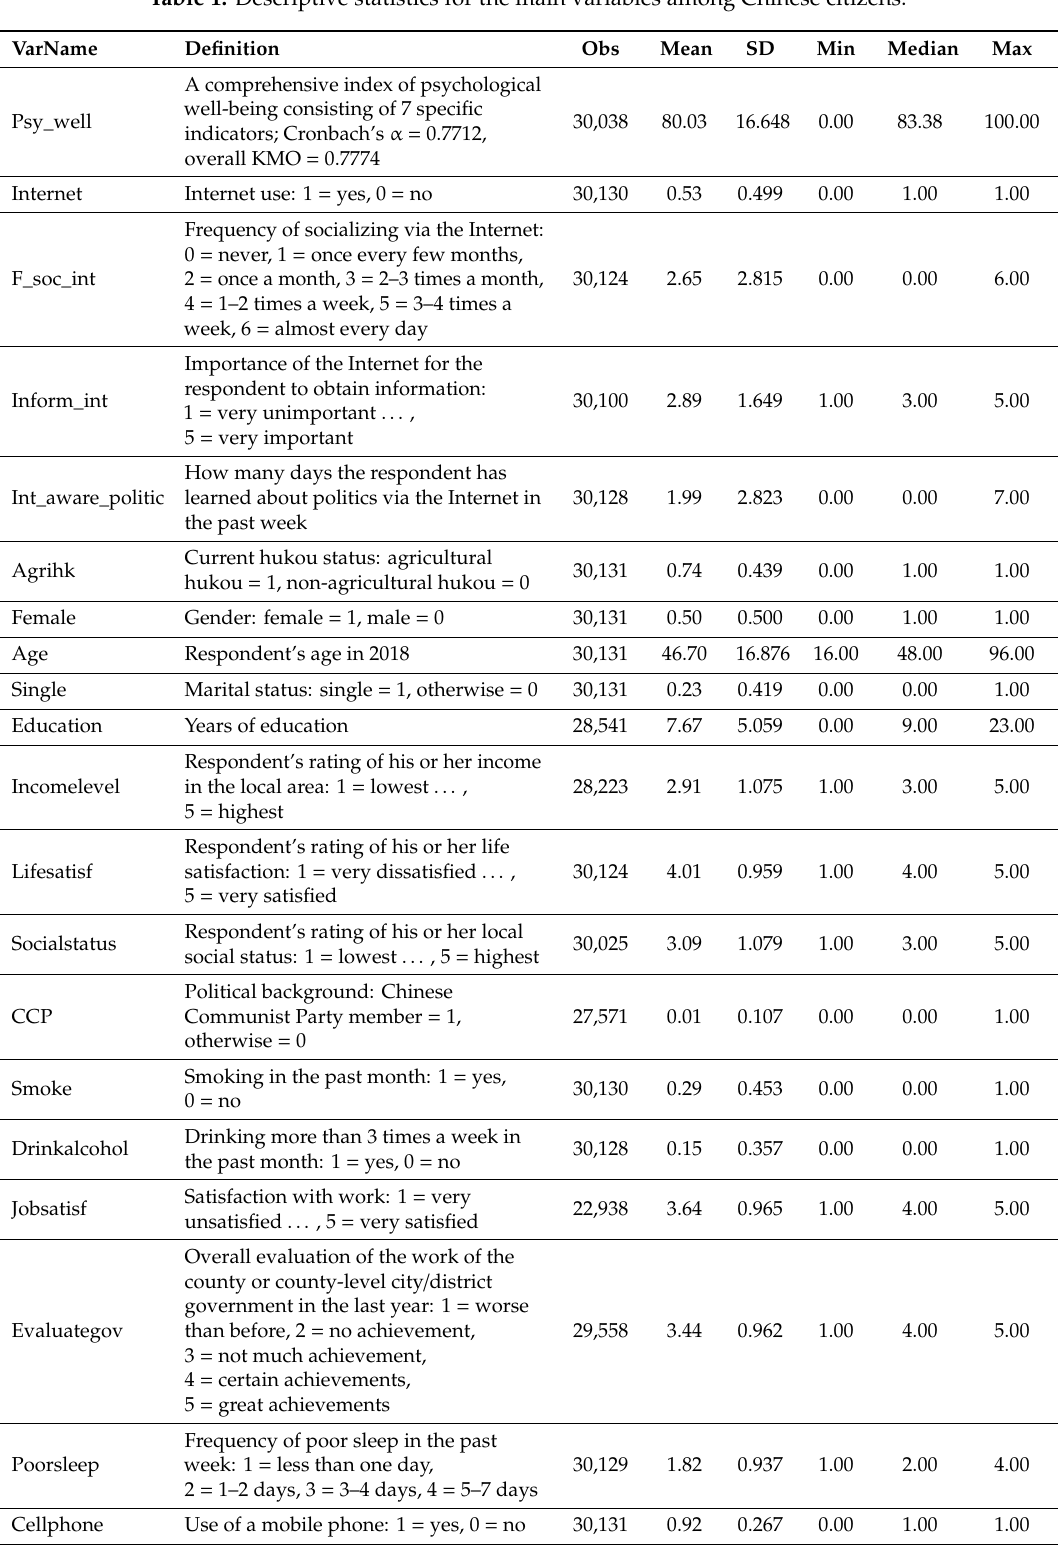
Table 1. Descriptive statistics for the main variables among Chinese